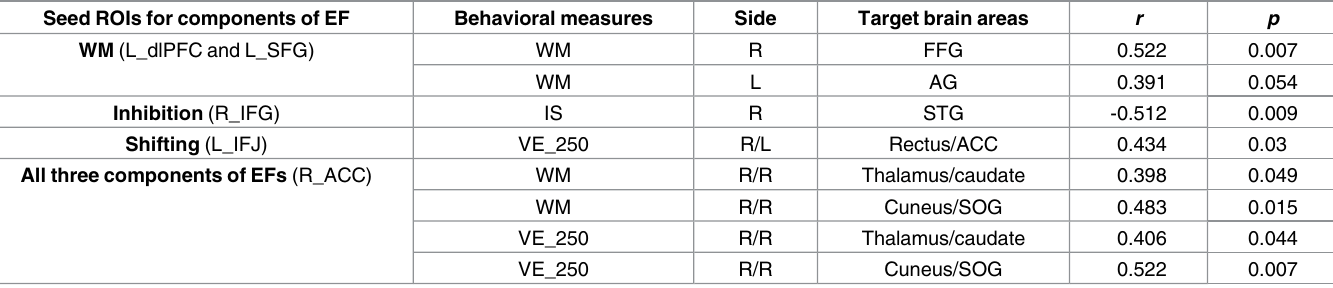
Table 5. Partial correlations between behavioral measuresand averagedRSFC between seed ROIs for a given component of EF and target brain areasof the CCH group after controlling for age, gender, and IQ. Seed ROIs for components of EF Behavioral measures Side Target brain